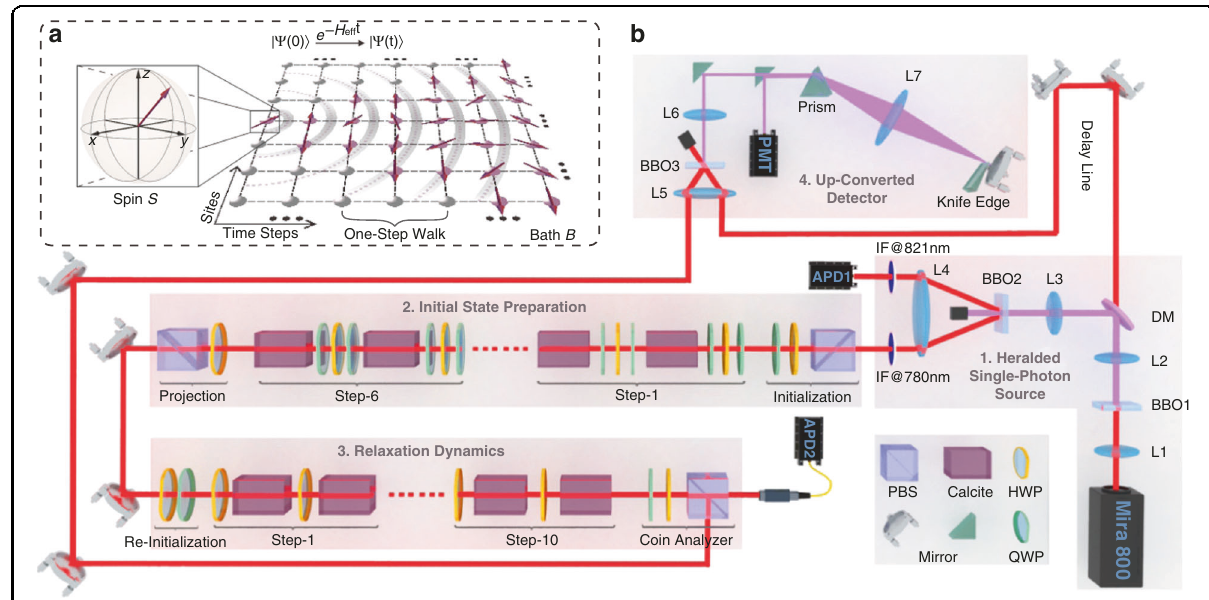
Fig. 2 Quantum walk model and the experimental setup. a A diagram of an isolated QW for investigating the generalized thermalization, which contains two parts: the discrete in fi nite lattice B and spin (coin) subsystem S , coupled by the spin – orbit interaction. b The experimental realization of QW involves the following four modules. (1) Pairs of photons are generated via the spontaneous parametric down-conversion (SPDC) in the BBO2 crystal, where a photon from each pair is directly detected by the APD1 as a trigger and the other signal one as the walker is sent to the subsequent module. (2) First, a localized state is initialized via a PBS-HWP-QWP setting. Second, the signal photons go through at most six steps of walk with each step involving two SU(2) coin tossings achieved by the combination QWP-HWP-QWP and two shift operators achieved by the calcite crystals. An arbitrary Gaussian wavepacket over the lattice space can be obtained after projecting the coin on an unbiased basis þj i using an HWP and PBS. (3) After re-initialization of the coin state (here the time step is also re-initialized as t = 0) and sending the signal photons into a 10-step walk whose coin- tossing rotations along the y-axis and achieved by utilizing the HWP, the relaxation evolution of the coin state can be monitored through a coin analyzer. (4) The time-evolving probability distributions, i.e., the pulse train of signal photons with a time interval of approximately 5 ps, can be analyzed by utilizing the up-converted detector, which comprised a frequency upconversion in the BBO3 crystal, a 4-f system for fi ltering the spectrum, and a PMT detector. The 4-f system includes a prism for introducing dispersion, a knife-edge for blocking the noise photons whose wavelength is longer than 395 nm, and a mirror re fl ecting the up-converted signal photons to the PMT. List of the abbreviations: lens (L); β -BaB 2 O 4 (BBO); avalanche photodiode detector (APD); dichroic mirror (DM); polarization-dependent beam splitter (PBS); half-wave plate (HWP); quarter-wave plate (QWP); photomultiplier tube (PMT). Detailed descriptions are provided in the